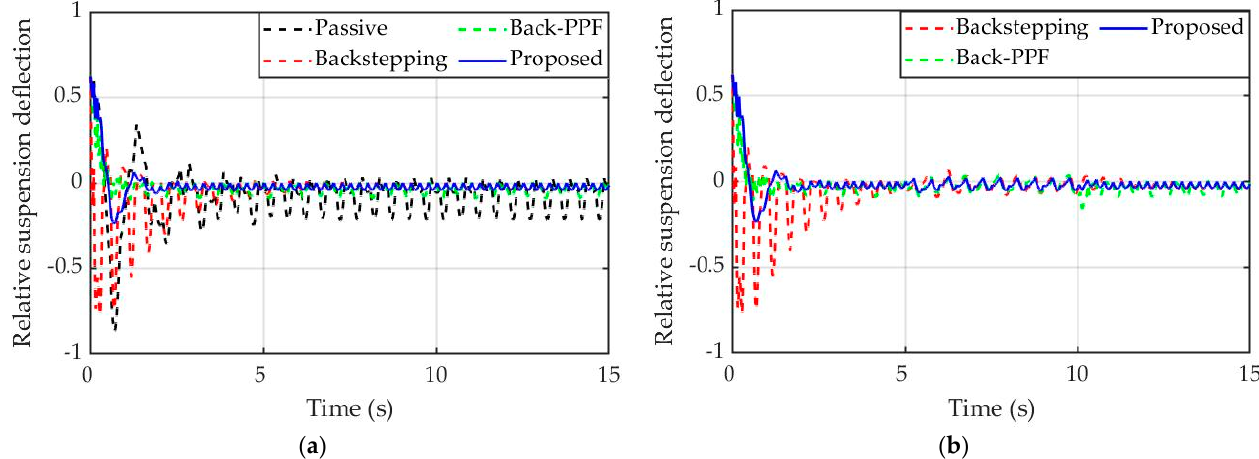
Figure 7. Relative suspension deflection responses: ( a ) Non-fault; ( b ) Actuator-fault.